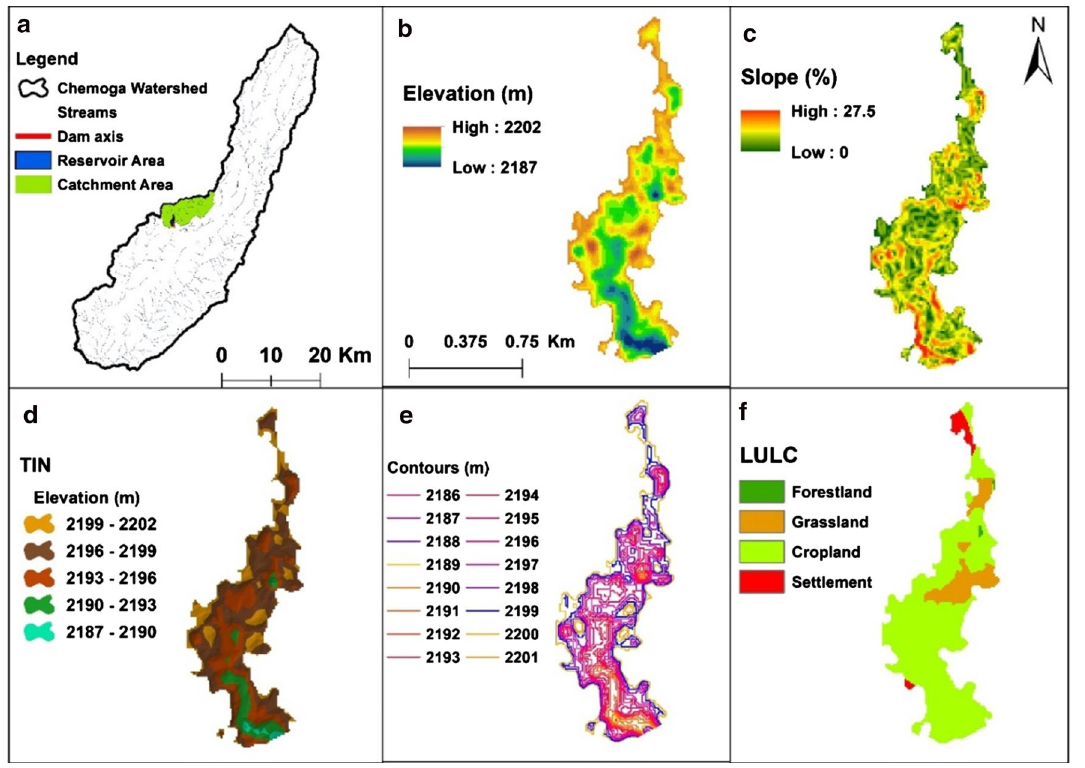
Fig. 14 Evaluation parameters for proposed Dam site 2: a Catchment area, b DEM, c slope, d triangulated irregular network (TIN), e contours, f